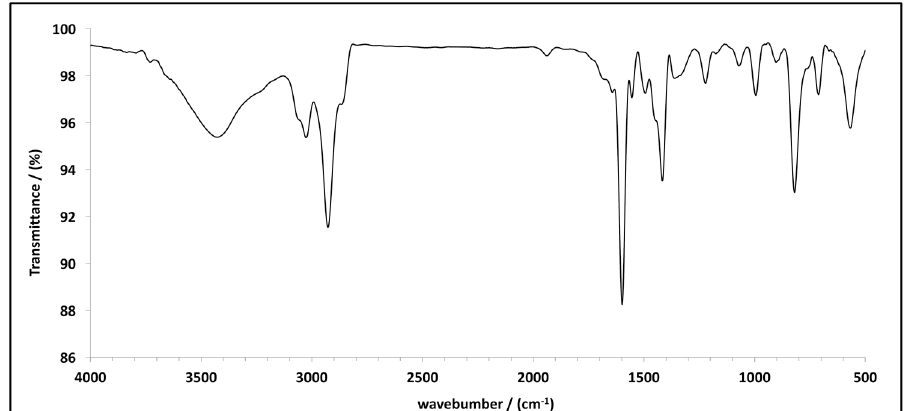
Figure 2. FT-IR spectrum of miniMIP 3 prepared for BPA.